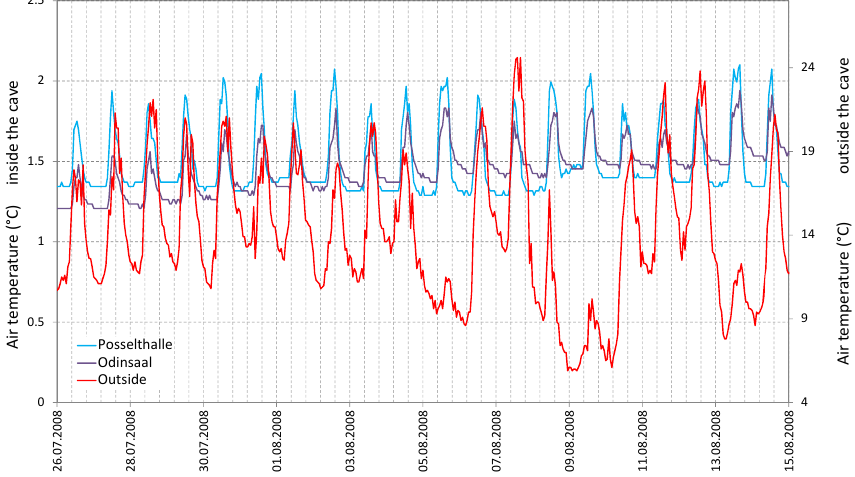
Fig. 8. Hourly values of air temperature difference (outside at the level of cave main entrance minus site Posselthalle unten), air temperature (green line=AWS close to the entrance, blue line=AWS in the middle part of the cave), wind speed and wind direction (bottom panel, AWS in the middle part of the cave only) in the cave Eisriesenwelt for the period 1 Decmeber 2007 to 31 May 2008. Wind direction values of +1 mean outward flow, values − 1 means inward flow. The shaded areas mark two examples of periods with inward air flow triggered from density gradients when the outside air is colder than inside the